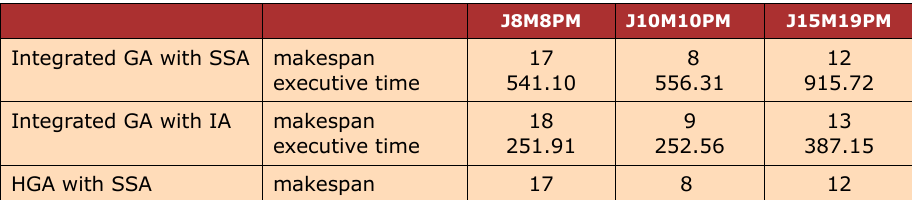
Table 5. Results of approach applied